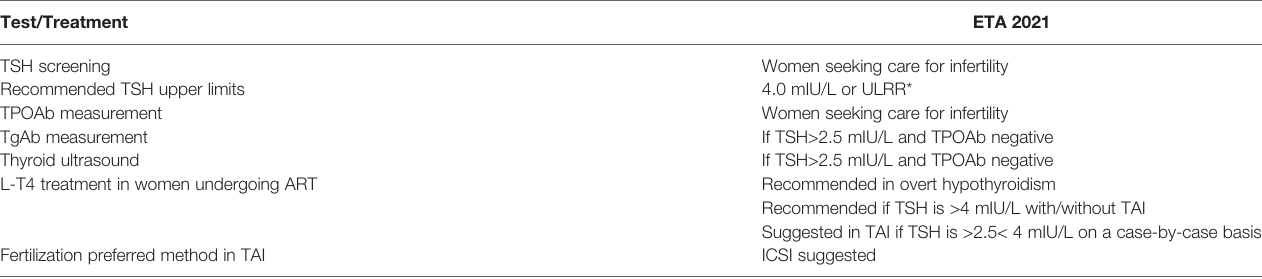
TABLE 3 | Recommendations for women with infertility and/or undergoing assisted reproductive technology (ART) according to the ETA 2021 guidelines (14). Test/Treatment